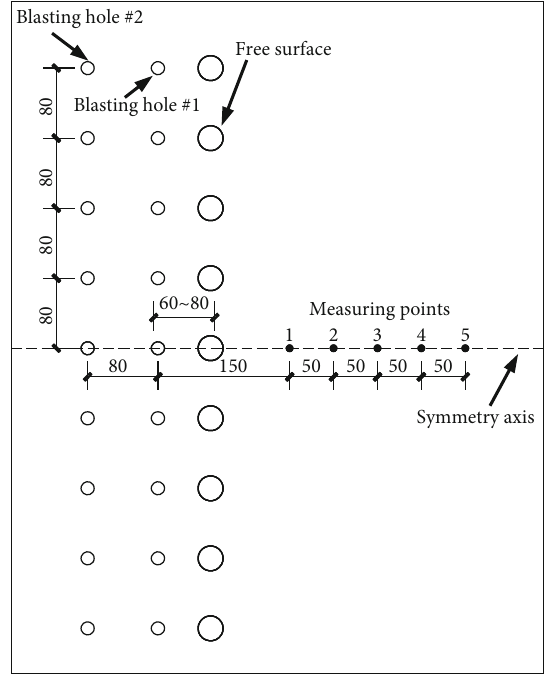
Figure 23: Particle selection diagram on the model